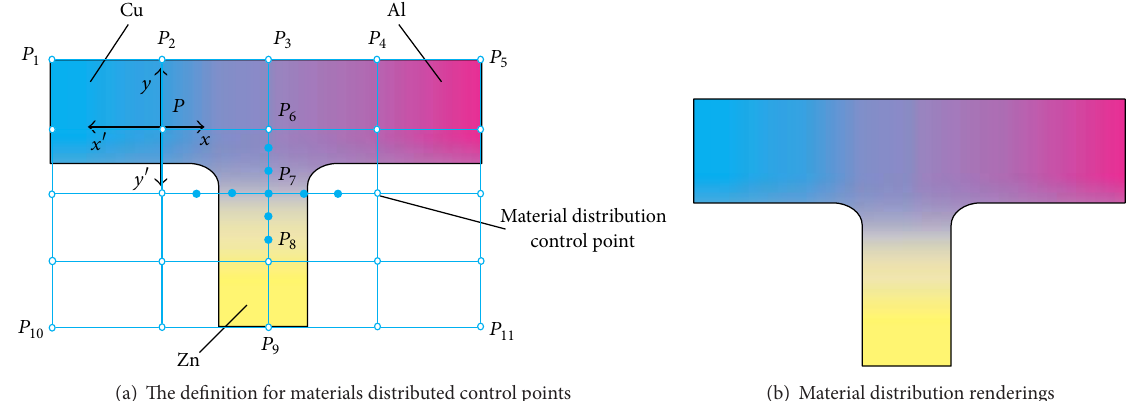
Figure 3: Material distribution definition.